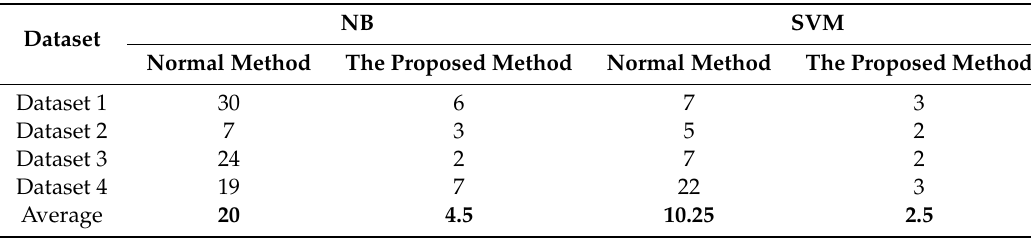
Table 4. MNSC comparison of classification with